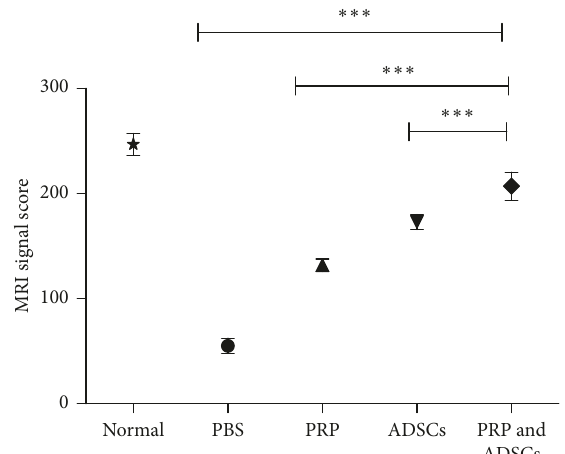
Figure 5: Compared with the negative control group, signal strength of the group of PRP, ADSCs, and PRP combination with ADSCs was remarkably high. Most important of all, PRP combination with ADSCs has the best effect in reversing degeneration.